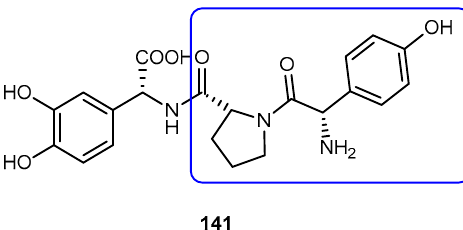
Figure 58. Tripeptide mimetic prodrug of 138 . A D - p -hydroxyphenylglycine- L -proline group (blue square) was attached to parent drug.